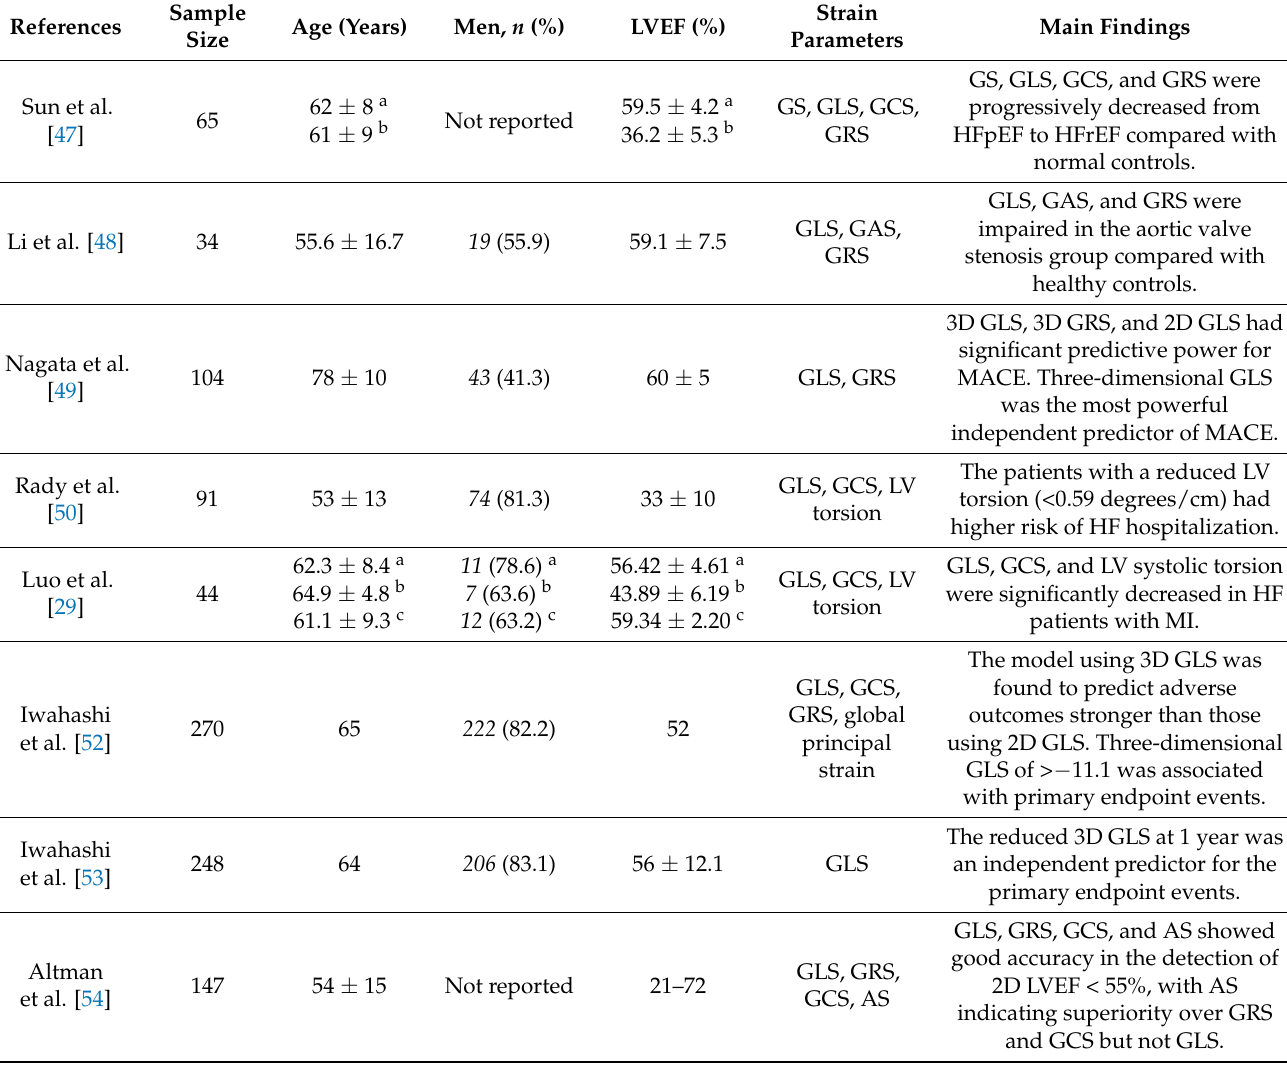
Table 1. Assessment of LV global systolic function in HF patients using